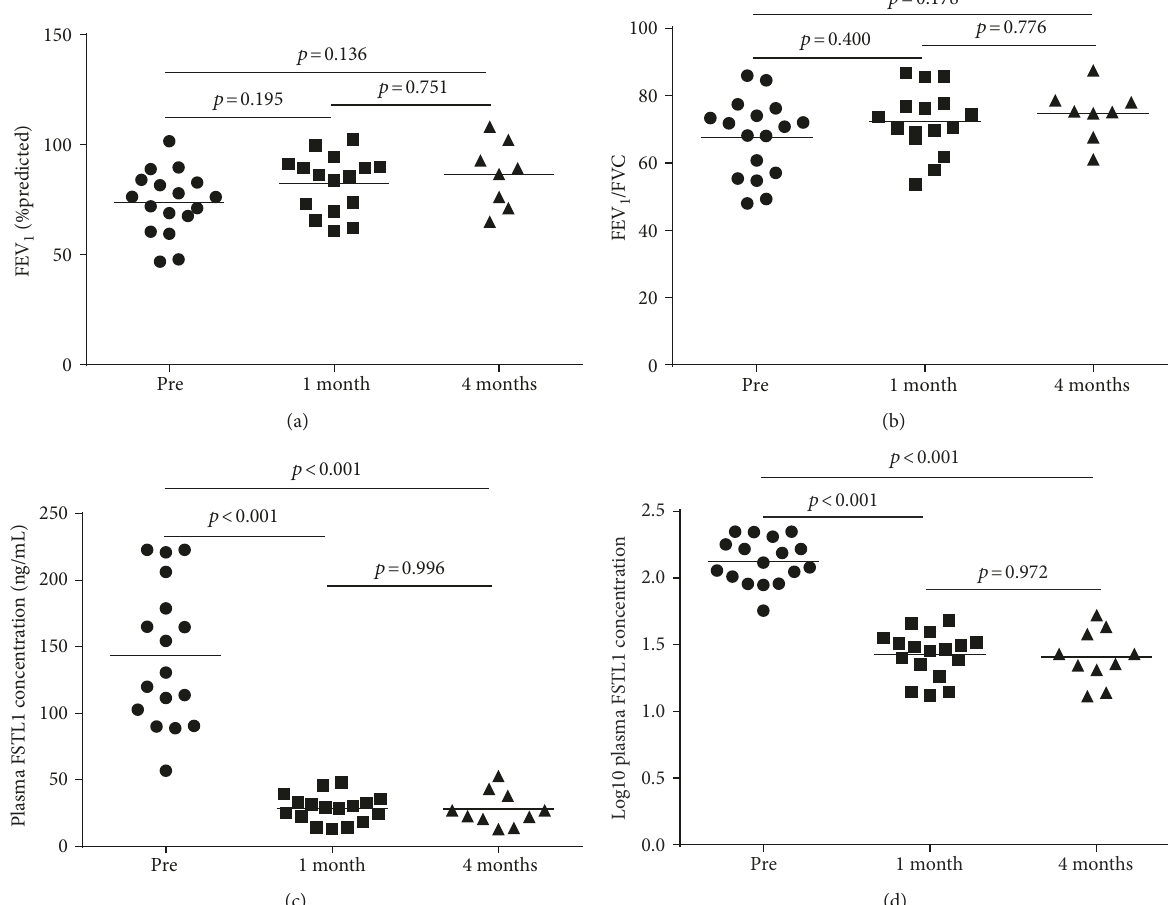
Figure 6: The changes of spirometry and FSTL1 levels before and after treatment. (a) FEV posttreatment, and 4 months posttreatment. (b) FEV (c) Plasma FSTL1 concentration before treatment, 1 month posttreatment, and 3 months posttreatment. (d) Log concentrations before treatment, 1 month posttreatment, and 3 months posttreatment. Multiple comparison was performed by Games-Howell test. Line indicates